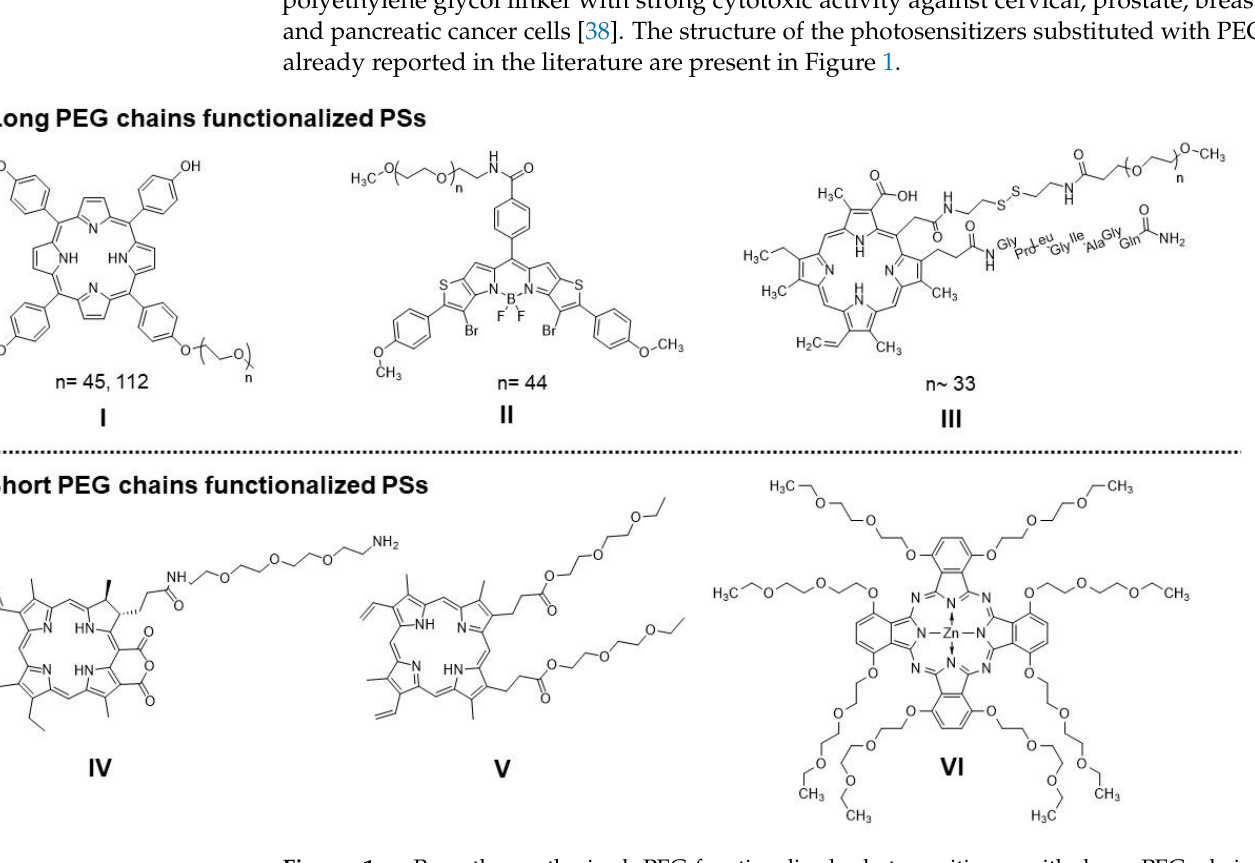
Figure 1. Recently synthesized PEG-functionalized photosensitizers with long PEG chains: I— 5,10,15,20-tetrakis(4-hydroxyphenyl)porphyrin (p-THPP) [39], II—3, 7-dibromo-2, 8-di (4-methoxy- phenyl)-11-(phenyl-4-carbamoylo-PEG 2000 )-dithieno [2, 3-b]-[3, 2-g]-5, 5- difluoro-5-bora-3a, 4a-di- aza-s-indacene) [40], and III—PEGylated Chlorin e6 polypeptide [41]; and short PEG chains: IV— Purpurin-PEG3-Amine Zinc Complex [38], V—2,7,12,18-tetramethyl-13,17-bis(1,4,7-trioxanonylcar- bonylethyl)-3,8-divinylporphyrin [35], and VI—[1,4,8,11,15,18,22,25-octakis(1,4,7-trioxa- nonyl)phthalocyanine]zinc(II)